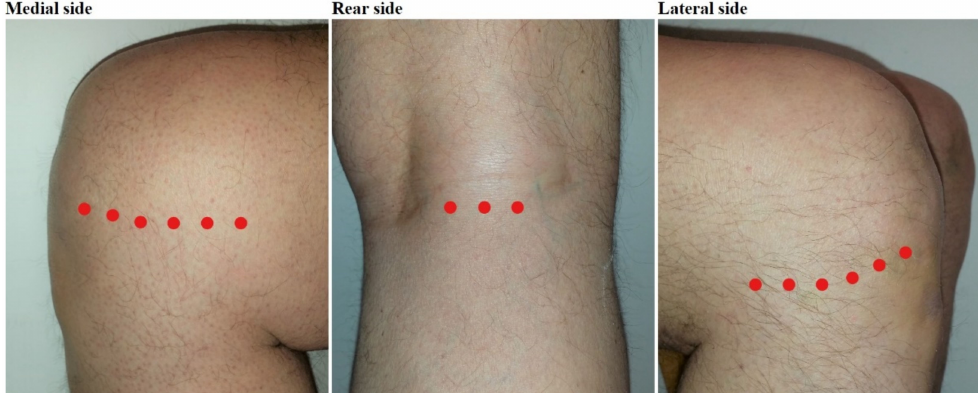
Figure 1. Treatment